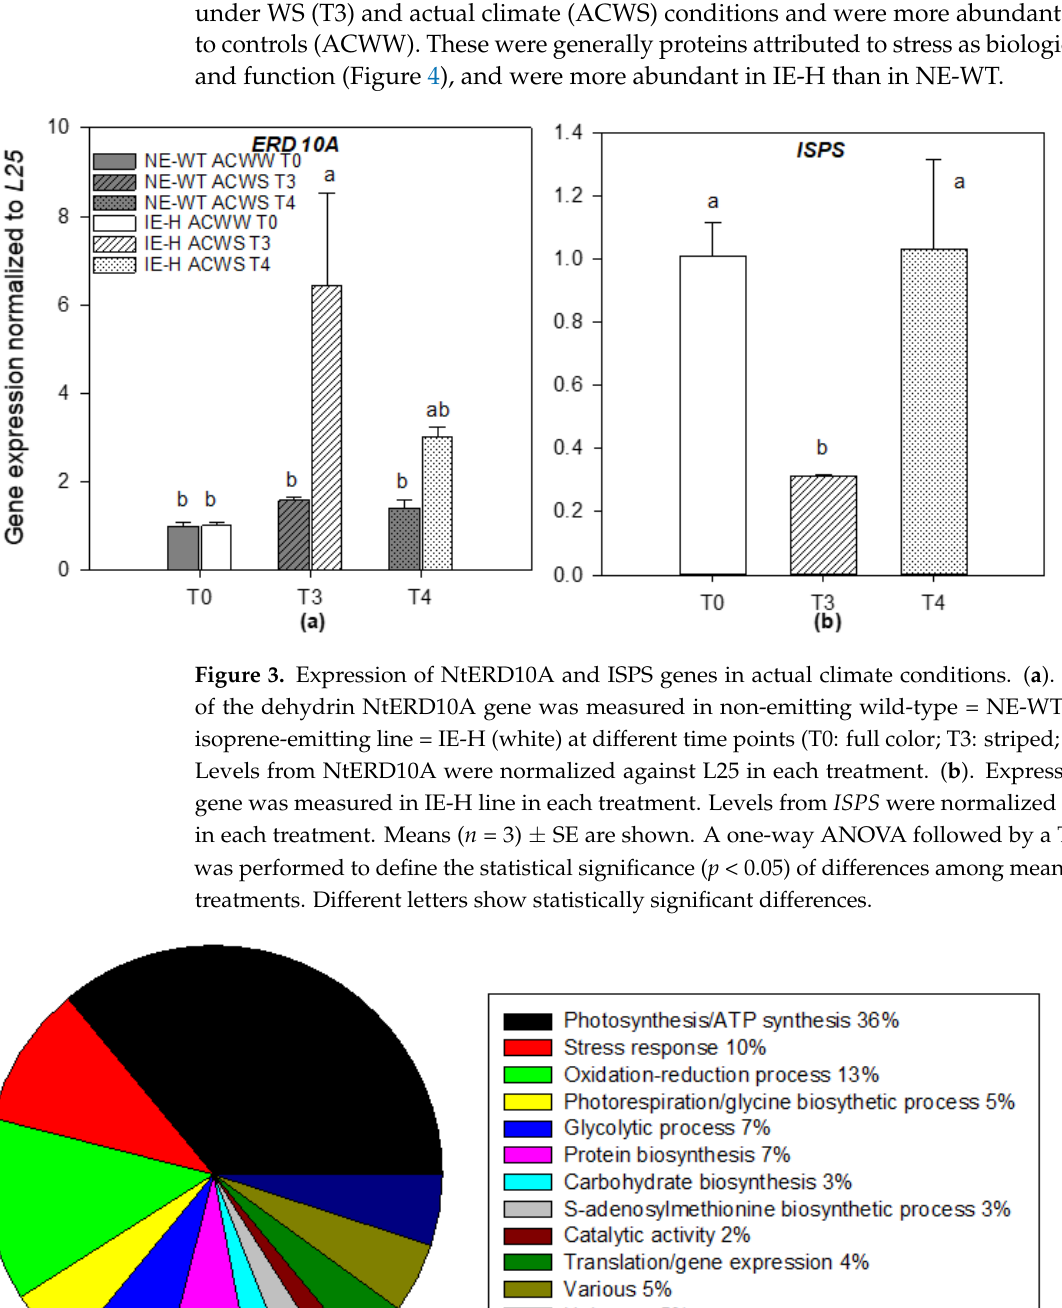
Figure 4. Proteomic overview in actual climate conditions. Proteins retrieved by our measurements of the proteome and separated into 12 different biological function groups. Groups were ordered accordingly to their percentage, calculated on a total of 359 different protein spots.